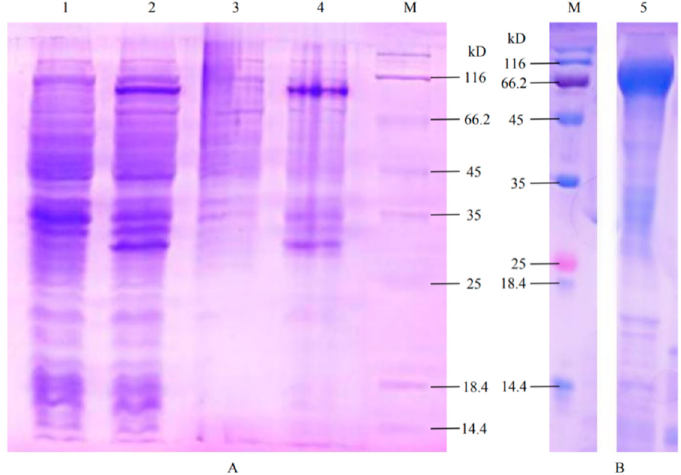
Figure 5. SDS-PAGE analysis of recombinant protein of MaCel1 in M . alternatus. ( A ): Induced expression of recombinant vector pET32a- MaCel1 ; (M): Standard for protein molecular weight; (1): Expression of pET32a- MaCel1 without IPTG induction; (2): The expression product of pET32a- MaCel1 after IPTG induction; (3): Expression product of pET32a- MaCel1 in supernatant; (4): Expression products of pET32a- MaCel1 in inclusion bodies; ( B ): Renaturation of MaCel1 purified protein; (5): MaCel1 renatured protein.